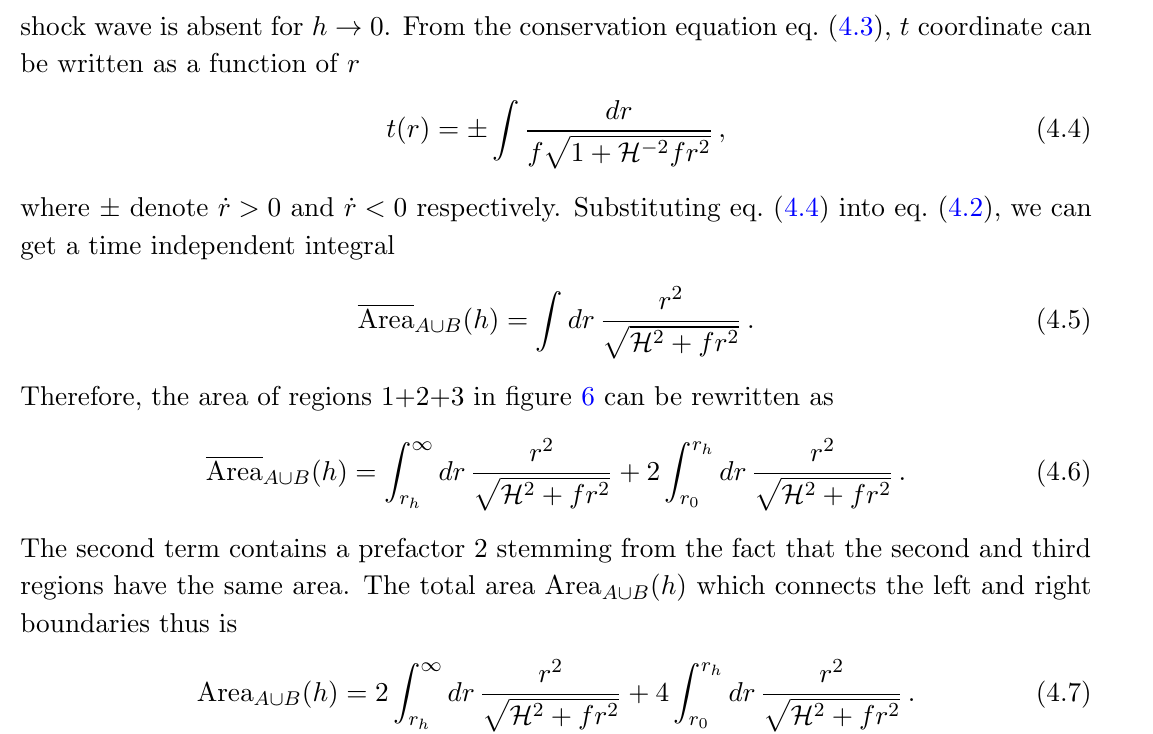
Figure 6 . The Penrose diagram of the shock wave geometry. The horizontal colorful line is the minimal surface connecting one of the two ends of the strips (one dot in the line represents a two dimensional surface spanned by ( x; y ) coordinates). The left half of the surface is divided into three segments, i.e., black line, red line and yellow line. The surface r = r 0 separates the line 2 and 3. shock wave is absent for h ! 0. From the conservation equation eq. (4.3), t coordinate